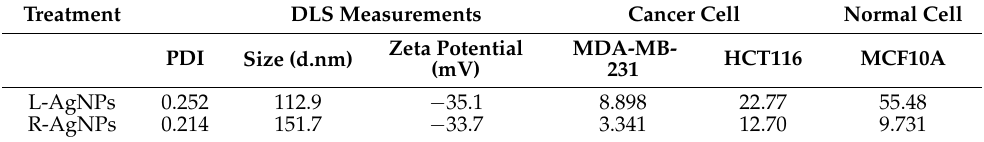
Figure 2. Size distribution of R-AgNPs. Table 1. Biogenic nanoparticle size and potential and IC 50 values ( µ g/mL) against different cell lines.